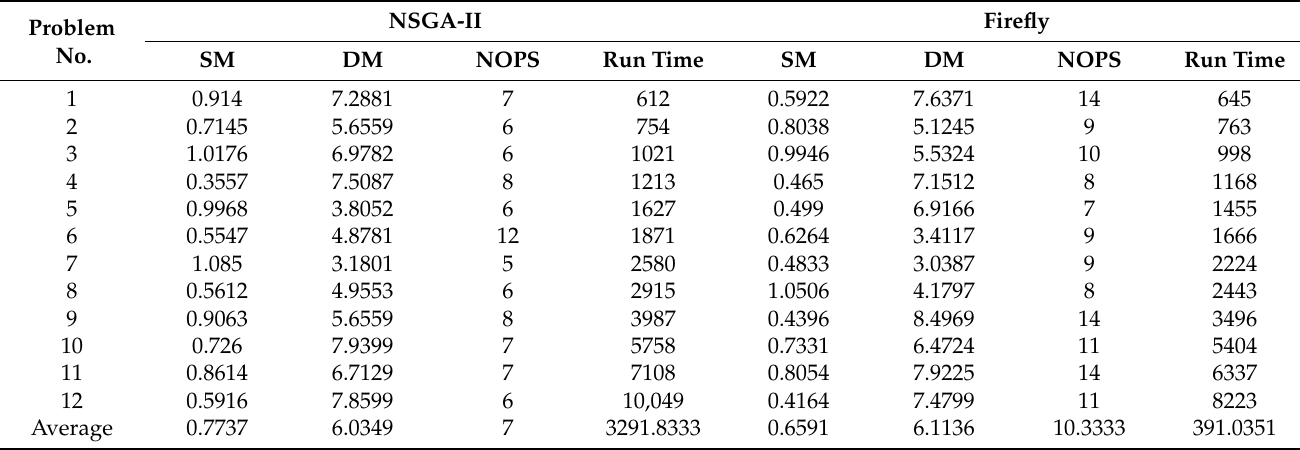
Table 7. Values of evaluations metrics for NSGAII and